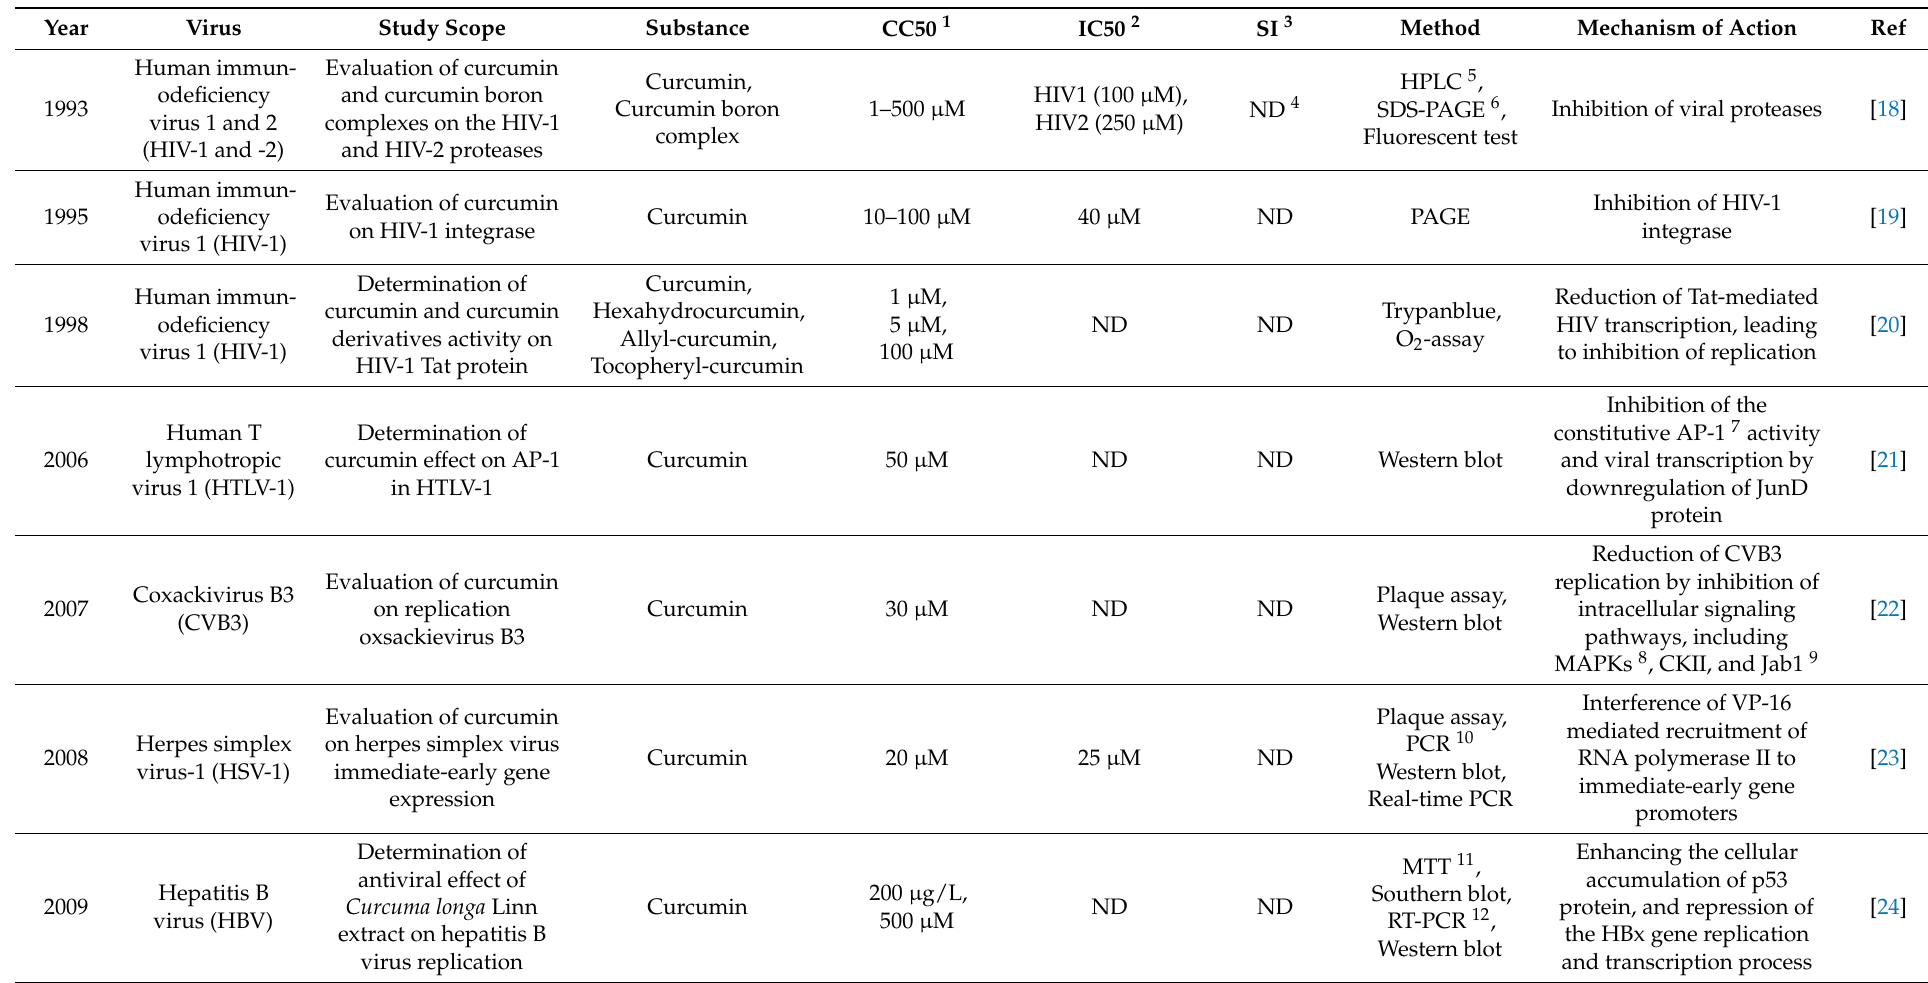
Table 1. Characteristics of selected studies on the anti-viral activity of curcumin and its